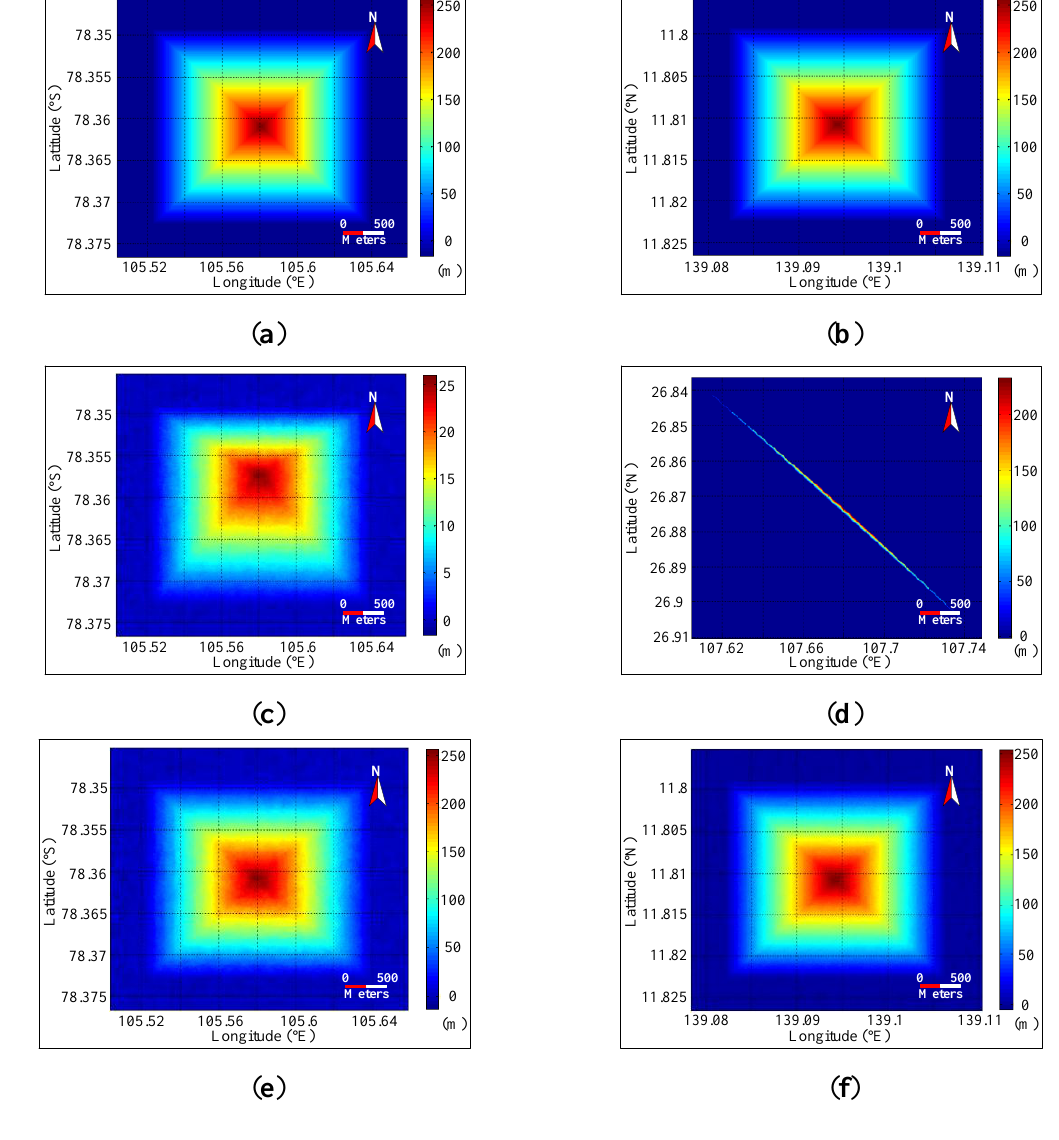
Figure 10. Reference DEMs at perigee ( a ) and above the Equator ( b ); generated DEM based on the conventional model at perigee ( c ) and above the Equator ( d ); generated DEM based on the proposed model at perigee ( e ) and above the Equator ( f